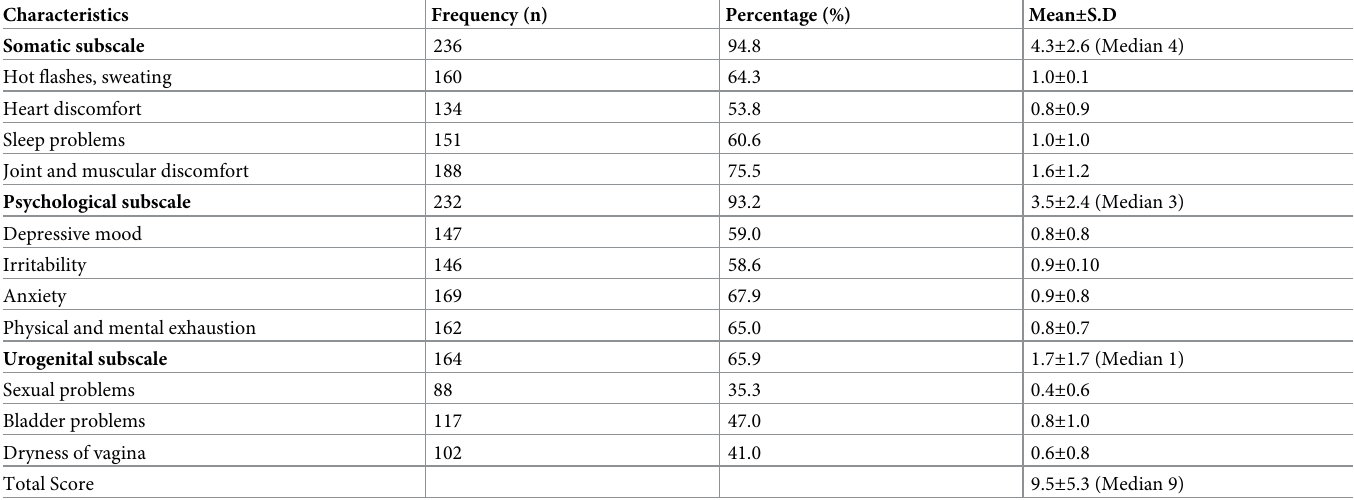
Table 2. Information regarding menopausal symptoms among menopausal women using the Menopausal Rating Scale (MRS). Characteristics